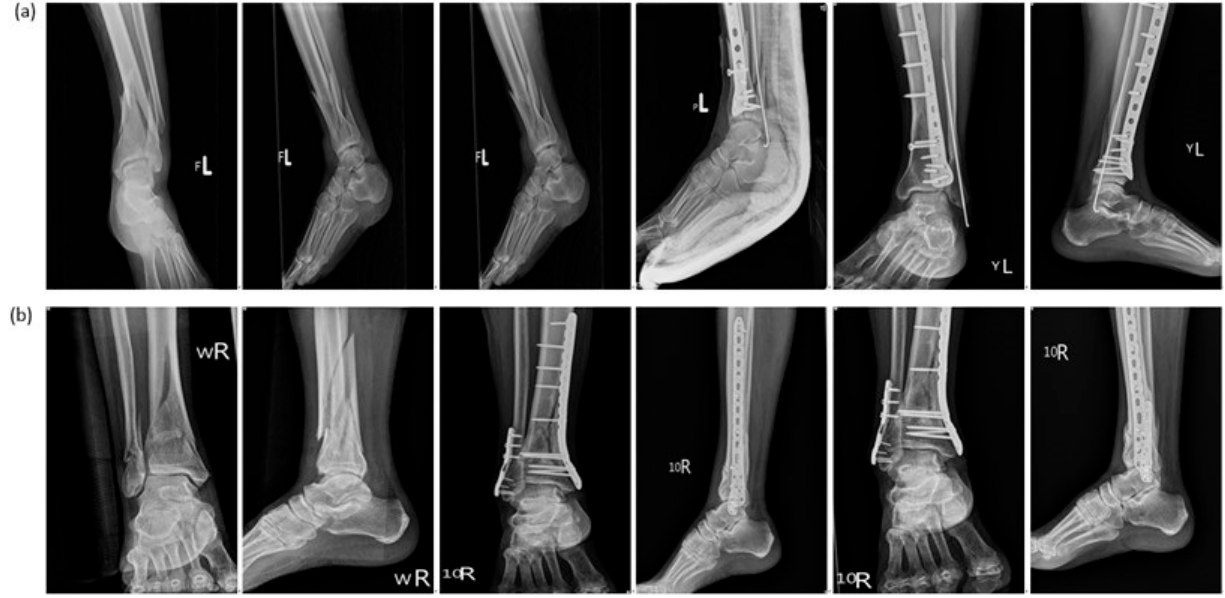
Figure 1. Patients were classified into two groups: ( a ) Group A—pilon fracture was fixed with the locking plate, and the distal fibula fracture was fixed with retrograde 2.0 mm K-pins; ( b ) Group B—pilon fractures and distal fibula fractures were both fixed with the locking plates.